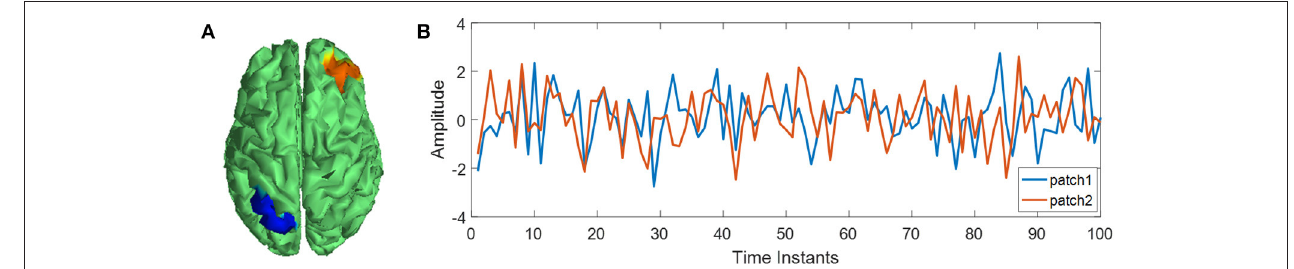
FIGURE 3 | Source activities for EEG simulation. (A) Location of two source patches; (B) activities of two source